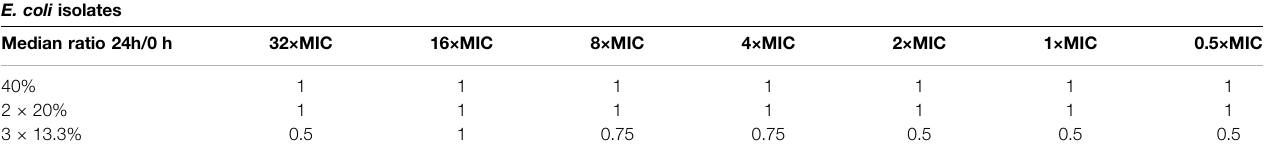
TABLE3| Themedianratiosoftheminimalinhibitoryconcentration(MIC)from24to0 haredepictedfor E.coli isolatesforallthreeregimensandalltestedconcentrations.A ratio at 1 or below indicates no change of the MIC. Ratios above 2 indicate an emergence of resistance. E. coli